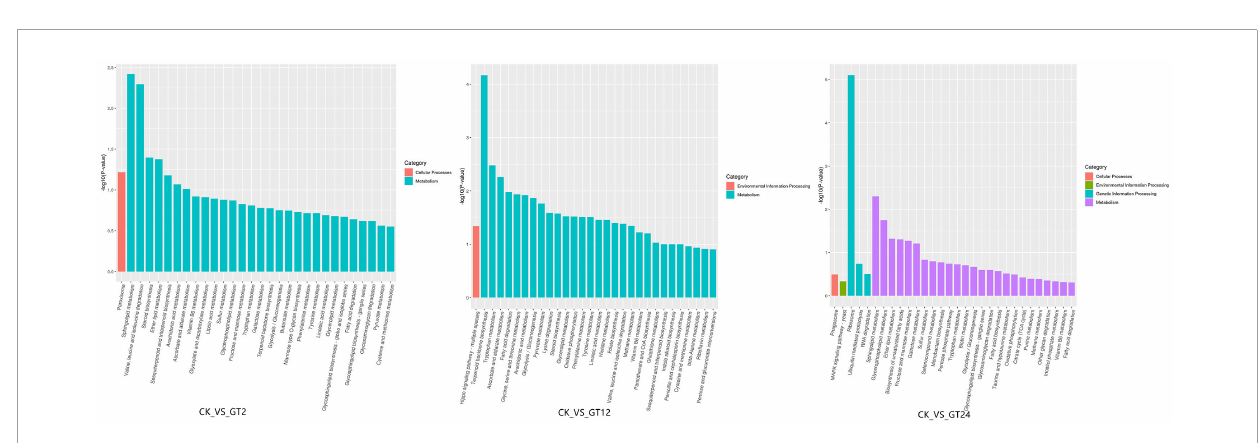
FIGURE3 Kyoto Encyclopedia of Genes and Genome (KEGG) pathway enrichment analyzes of differentially expressed genes (DEGs).